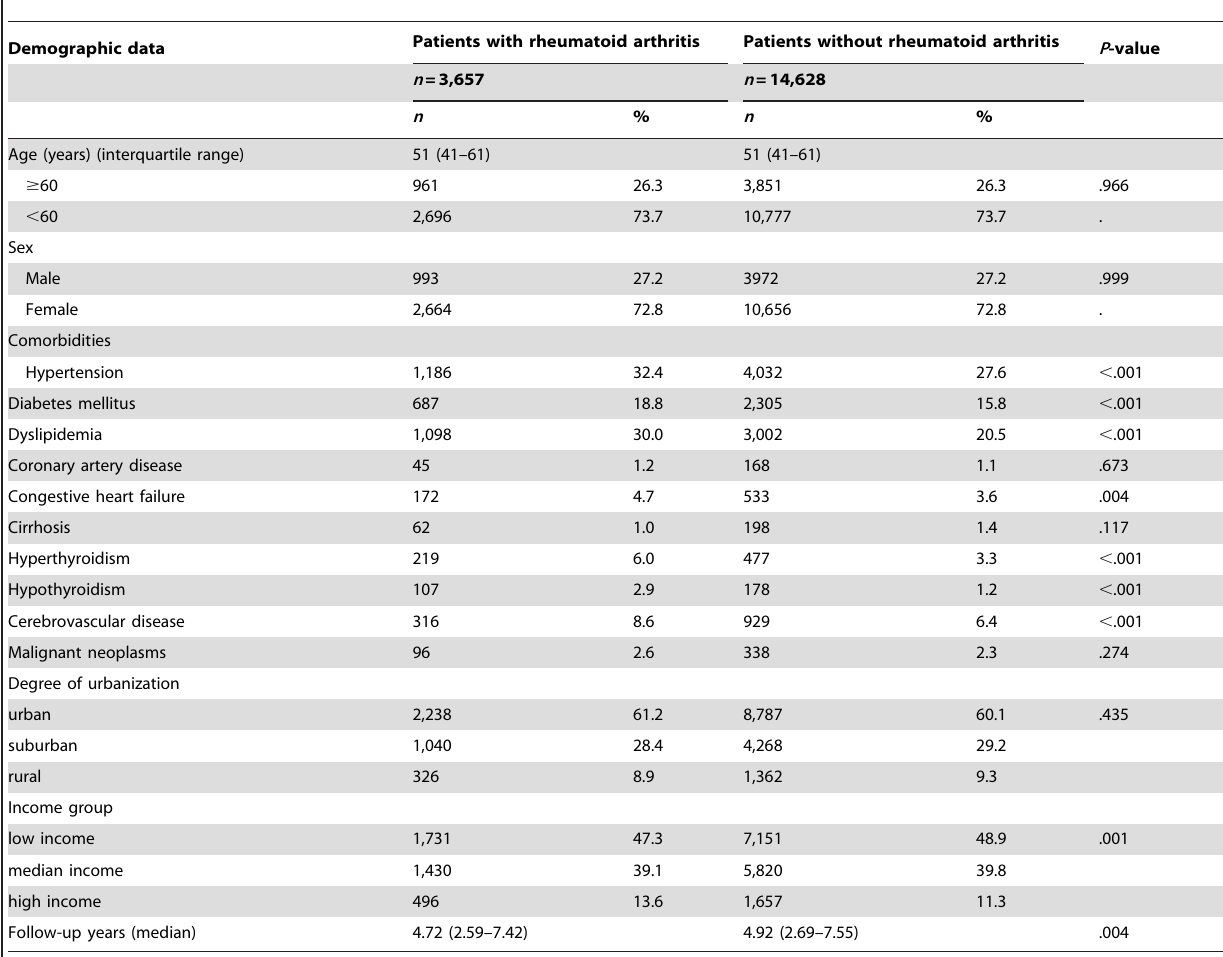
Table 1. Baseline Characteristics of Patients with and without Rheumatoid Arthritis.